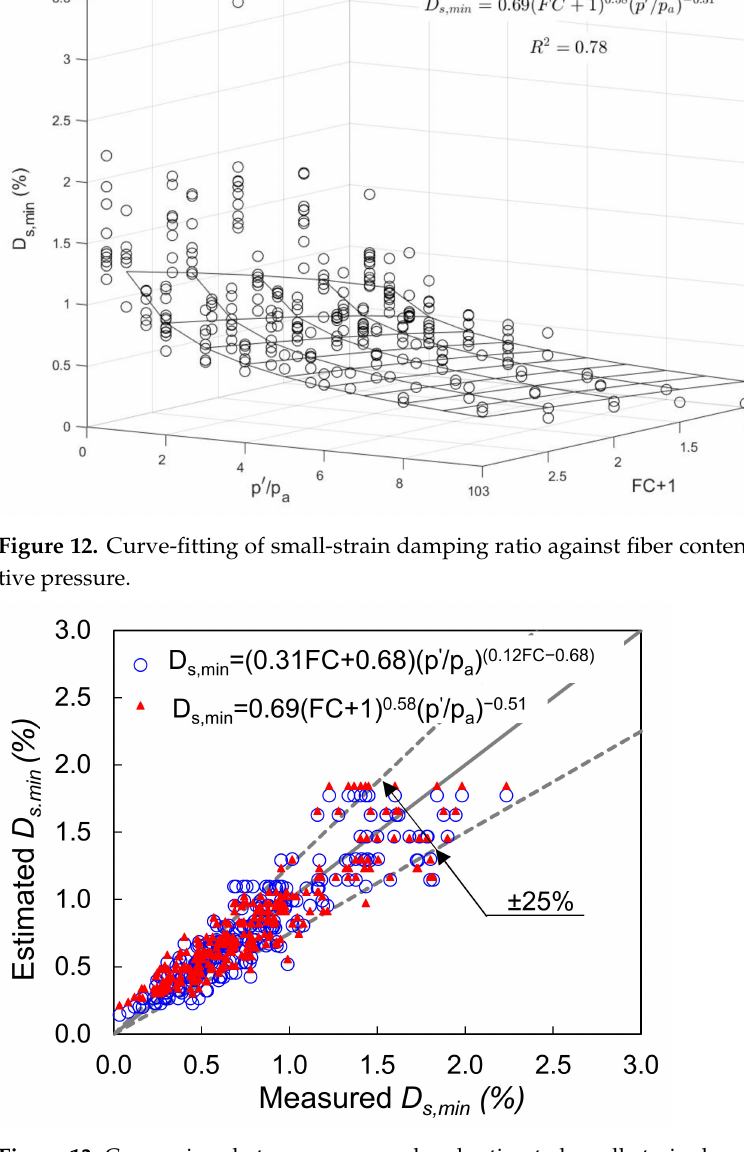
Figure 13. Comparison between measured and estimated small-strain damping